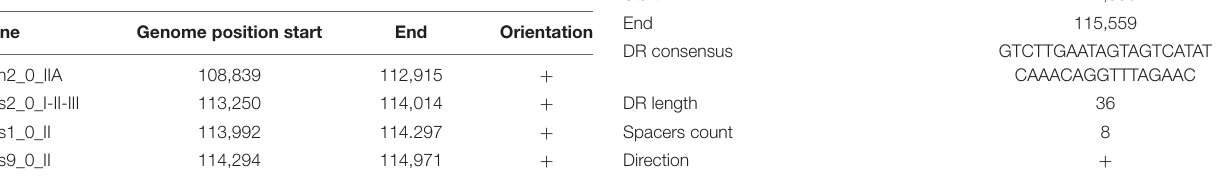
TABLE 3 | Genomic features of CRISPR-Cas system in Lpb. plantarum LT52.